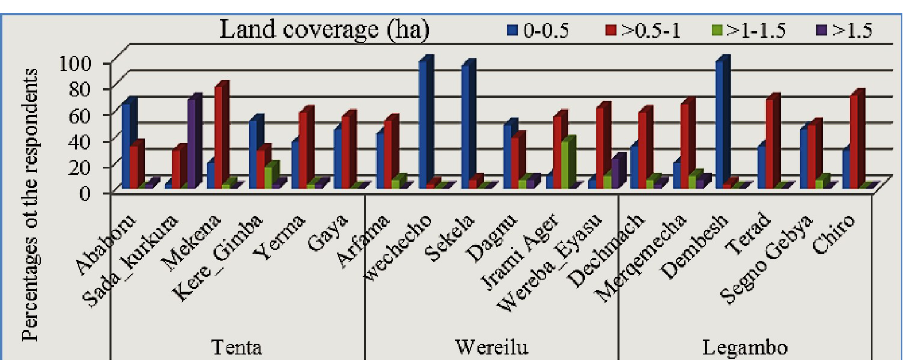
Fig 1. The land coverage by the barley landraces in each kebeles.